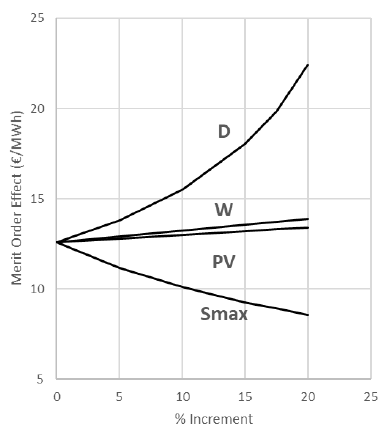
Figure 12. Sensitivity analysis (one factor at a time): Effect of crucial market factors on the merit order effect. D = demand, W = renewables except photovoltaics, PV = photovoltaics, and S max = conventional.